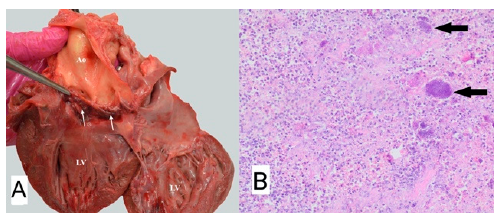
Figure 8. ( A ) Macroscopic view of vegetation of the aortic valve. White arrow points to thickened aortic valve leaflets with massive proliferative lesions, Ao—Aorta, LV—left ventricle. ( B ) Microscopic view of sample–necrotic and purulent inflammation with numerous bacterial colonies (arrows); H-E, magnification 100×.